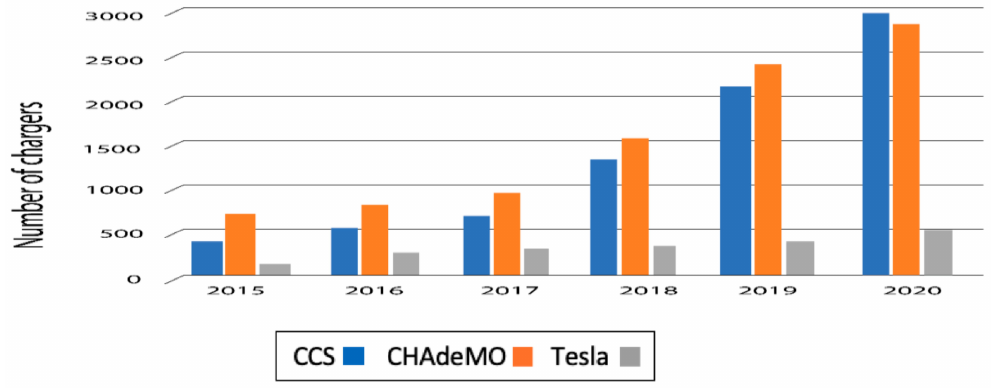
Figure 8. CCS vs. CHAdeMO vs Tesla UK charge point connector deployment [5,28]. The data in Figure 8. points to almost equal deployment of CHAdeMO and CCS charge